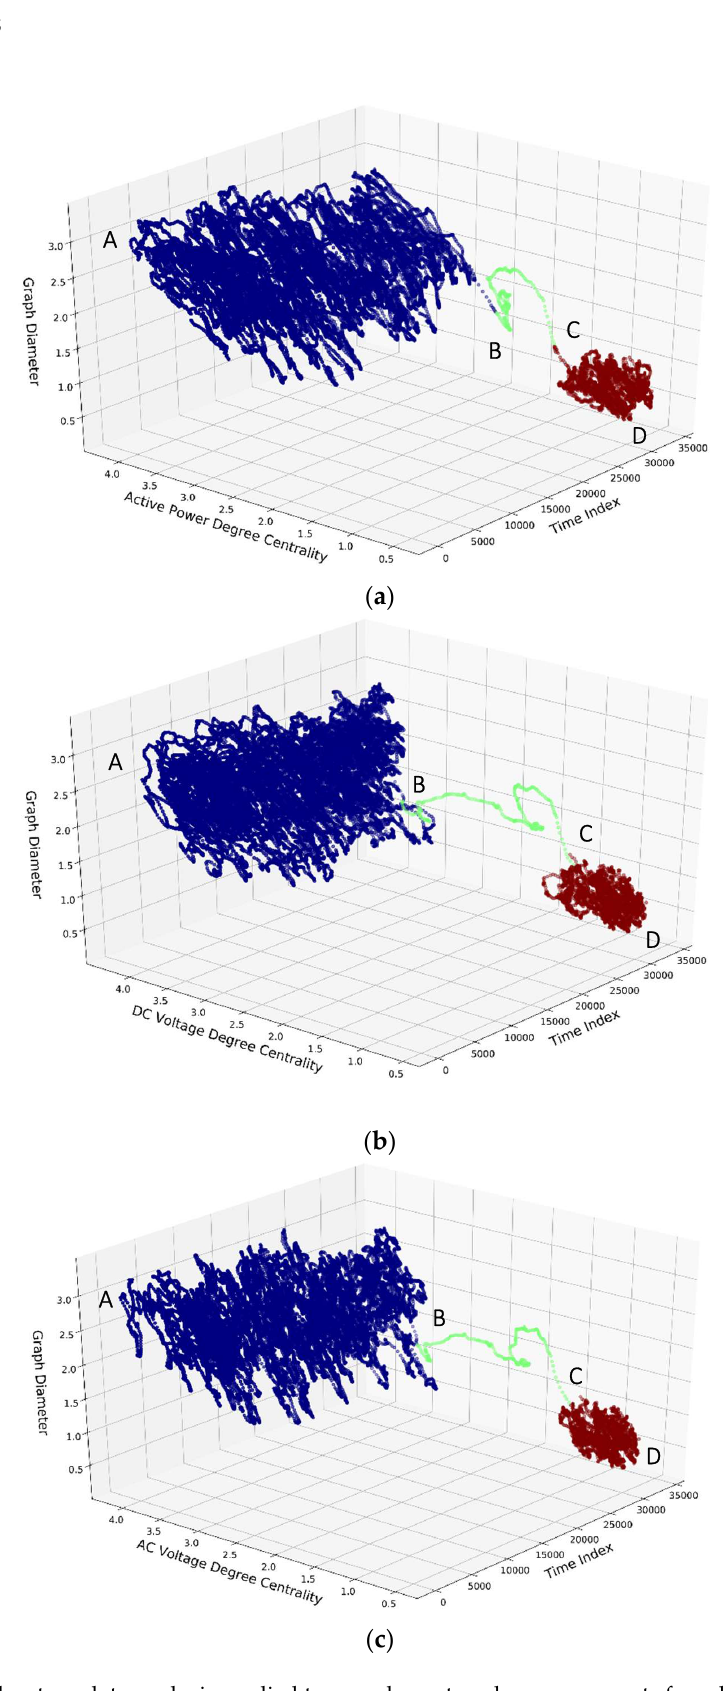
Figure 7. Exploratory data analysis applied to complex network measurements from block A of the inverter 1. Trends of ( a ) active power, ( b ) DC voltage and ( c ) AC voltage normalized weighted degree centralities (x-axis), against network diameter (y-axis) and time (z-axis).